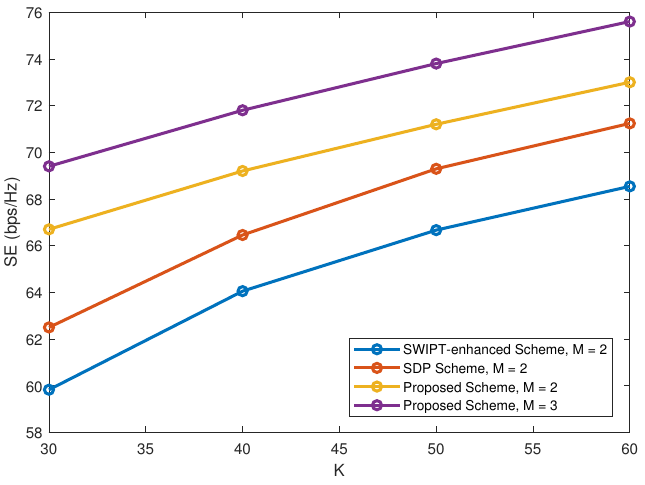
SWIPT-enhanced Scheme, M = 2 SDP Scheme, M = 2 Proposed Scheme, M = 2 Proposed Scheme, M = 3